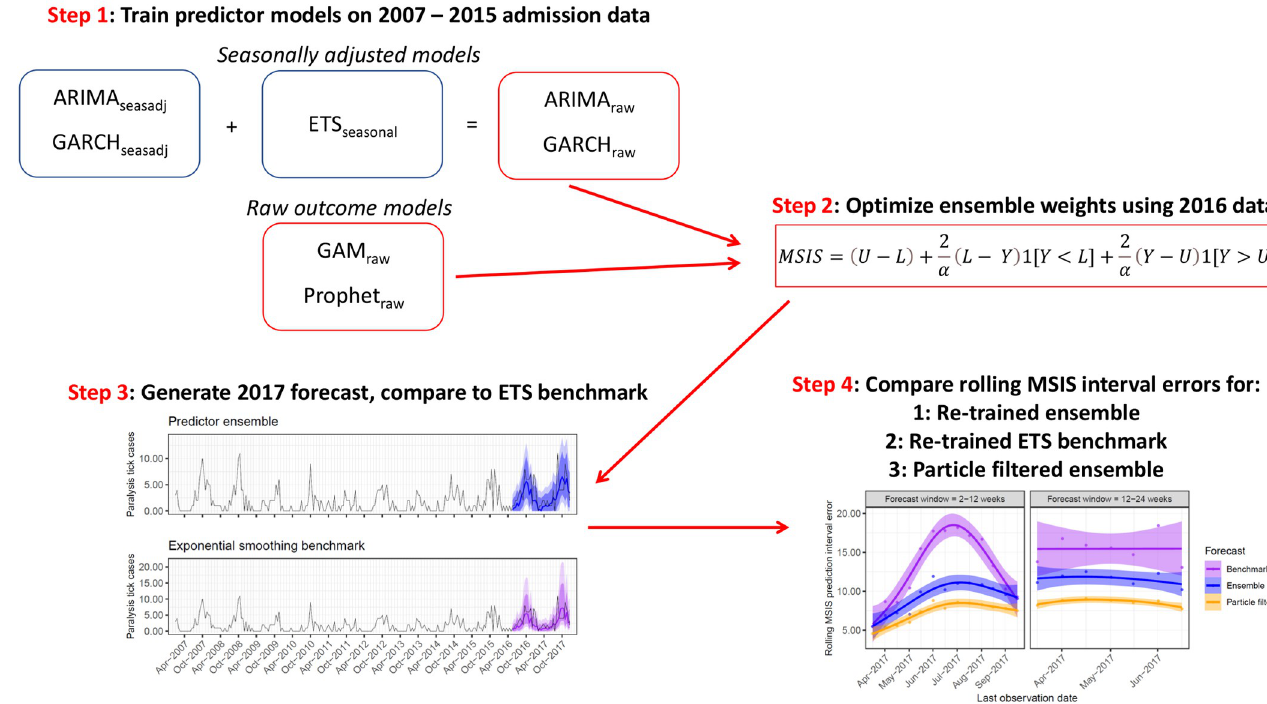
Fig 3. Schematic representation of the sequential process used to train and interrogate the ensemble forecast for tick paralysis admissions on the Sunshine Coast. ARIMA, Autoregressive Integrated Moving Average; GARCH; Generalized Autoregressive Conditional Heteroskedasticity; GAM, Generalized Additive Model; ETS, exponential smoothing; MSIS, Mean Scaled Interval